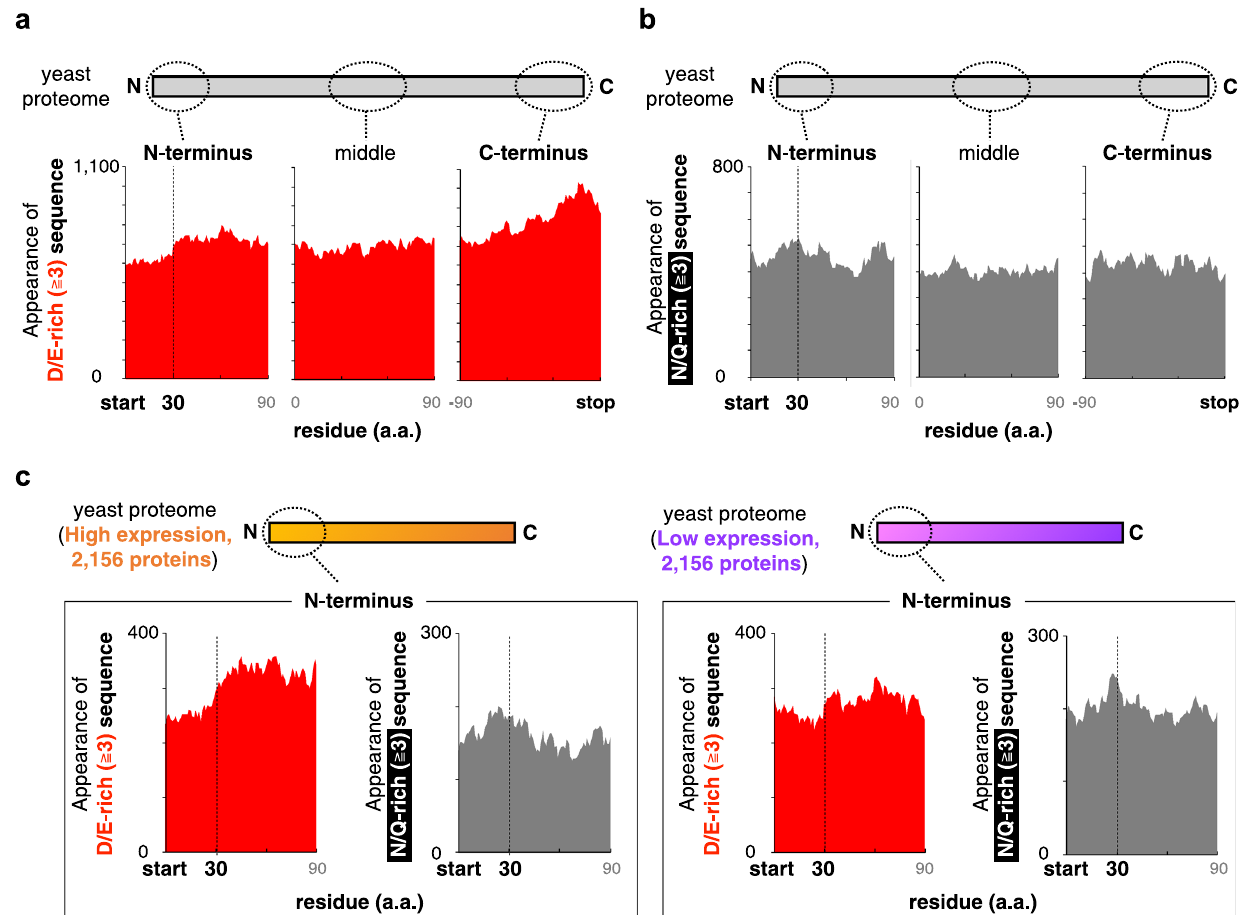
Fig.7|YeastproteomeavoidspositioningD/E-richsequencesintheN-terminal regions. a , b Amino acid composition of the yeast proteome. The vertical axis represents the number of proteins harboring ≥ 3 D/E ( a ) or N/Q ( b ) in a 10 residue- moving window. N-terminus, C-terminus, and middle region are de fi ned as N-terminal 100 amino acids excluding the fi rst methionine, C-terminal 100 amino